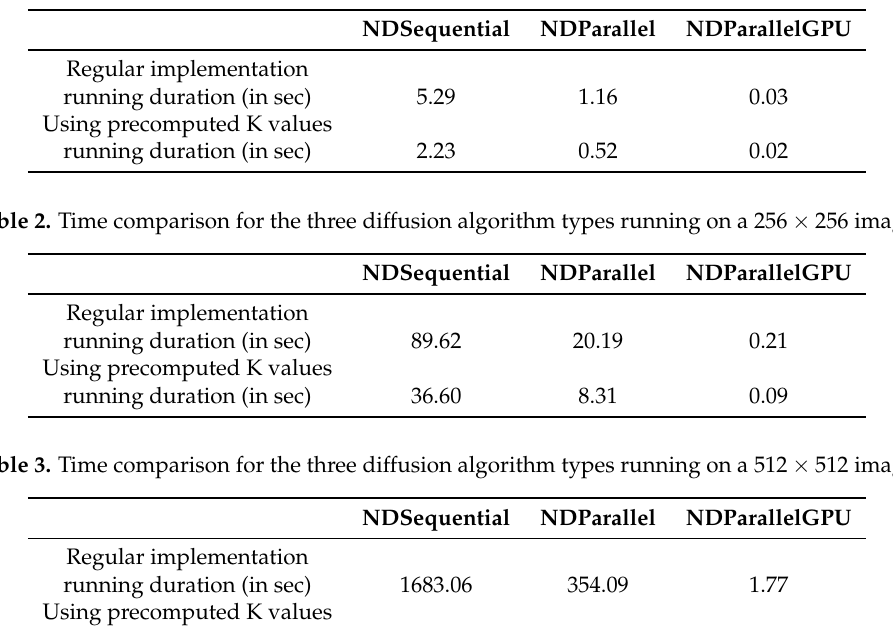
Table 1. Time comparison for the three diffusion algorithm types running on a 128 × 128 image.